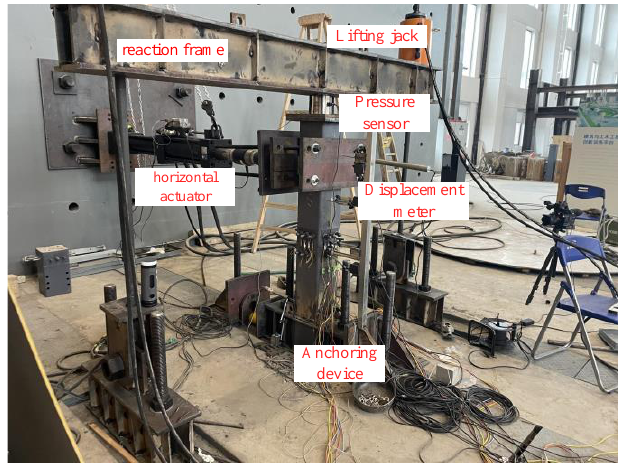
Figure 4. Test loading device.